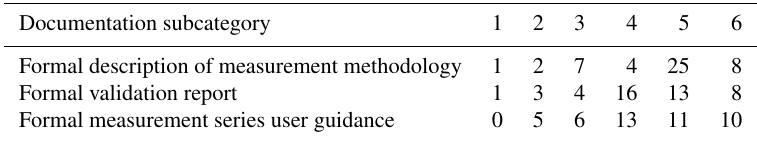
Table 3. Frequency of occurrence of the maturity matrix scores for the three subcategories (formal description of measurement methodology, formal validation report, formal measurement series user guidance) of the main category, documentation.